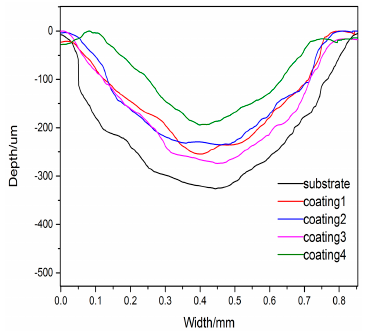
Figure 9. Friction coefficients of the substrate and laser cladding coatings at temperature.